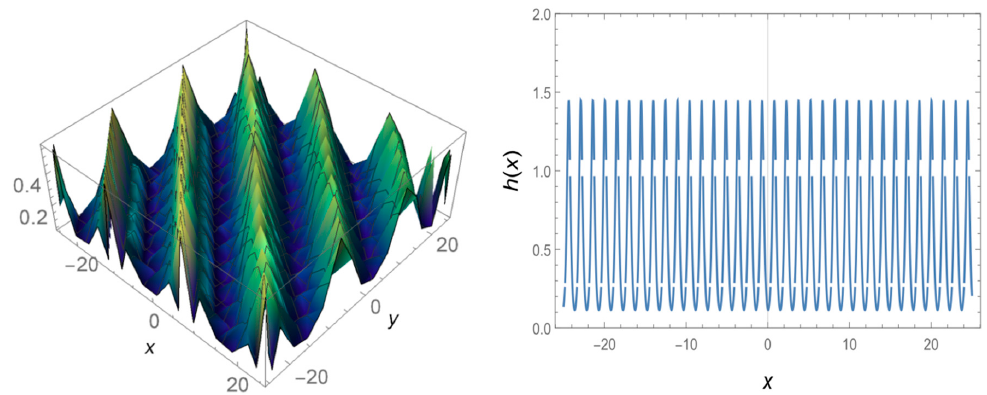
Figure 2. Three-dimensional and 2D graphs for values t = 2, θ 0 = 1, λ = 3, m = 2, µ = 0.5, d = 0.4, ρ = 2, τ = 1, (cid:36) = 1 of Equation (17) and y = 2 for 2D.